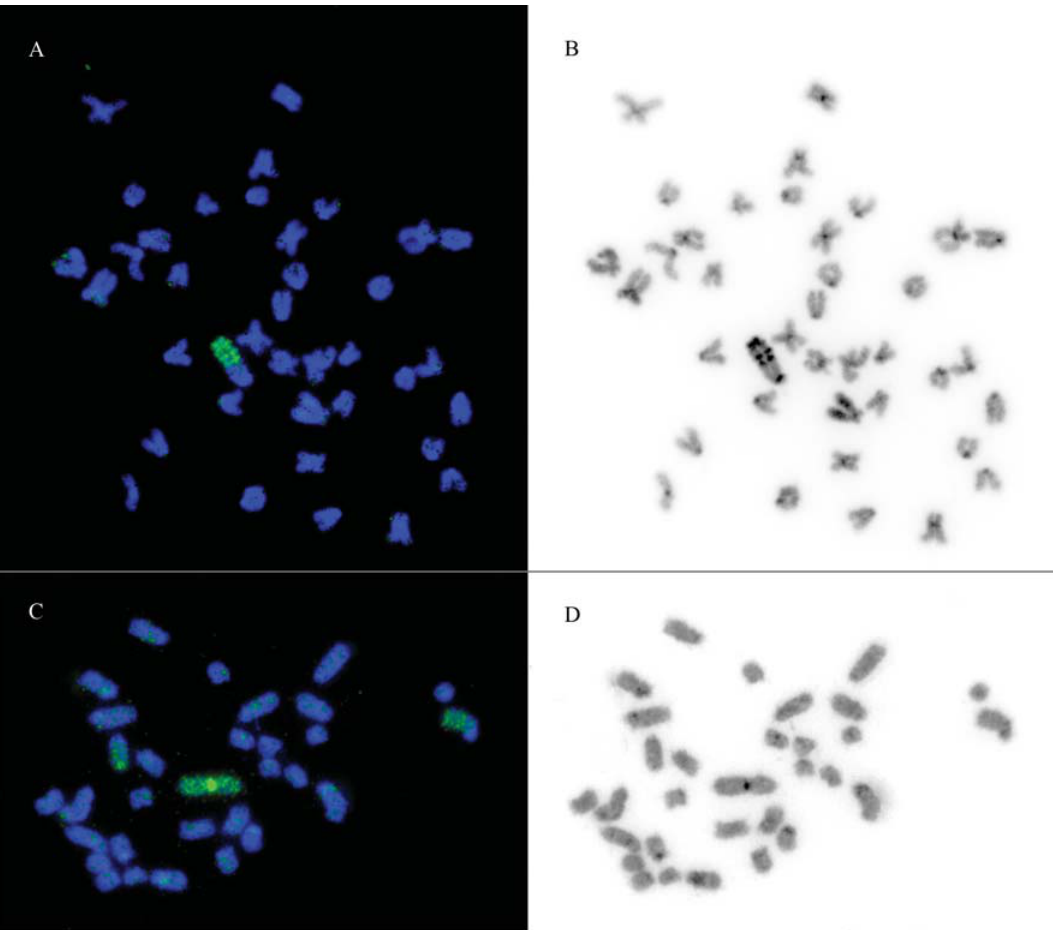
Figure 2 - Hybridization patterns using A) a probe developed from three copies of X chromosome heterochromatin of Eigenmannia virescens ; B) DAPI counterstain of A; C) a probe derived from Eigenmannia sp. 2 Y chromosome; D) DAPI counterstain of C.